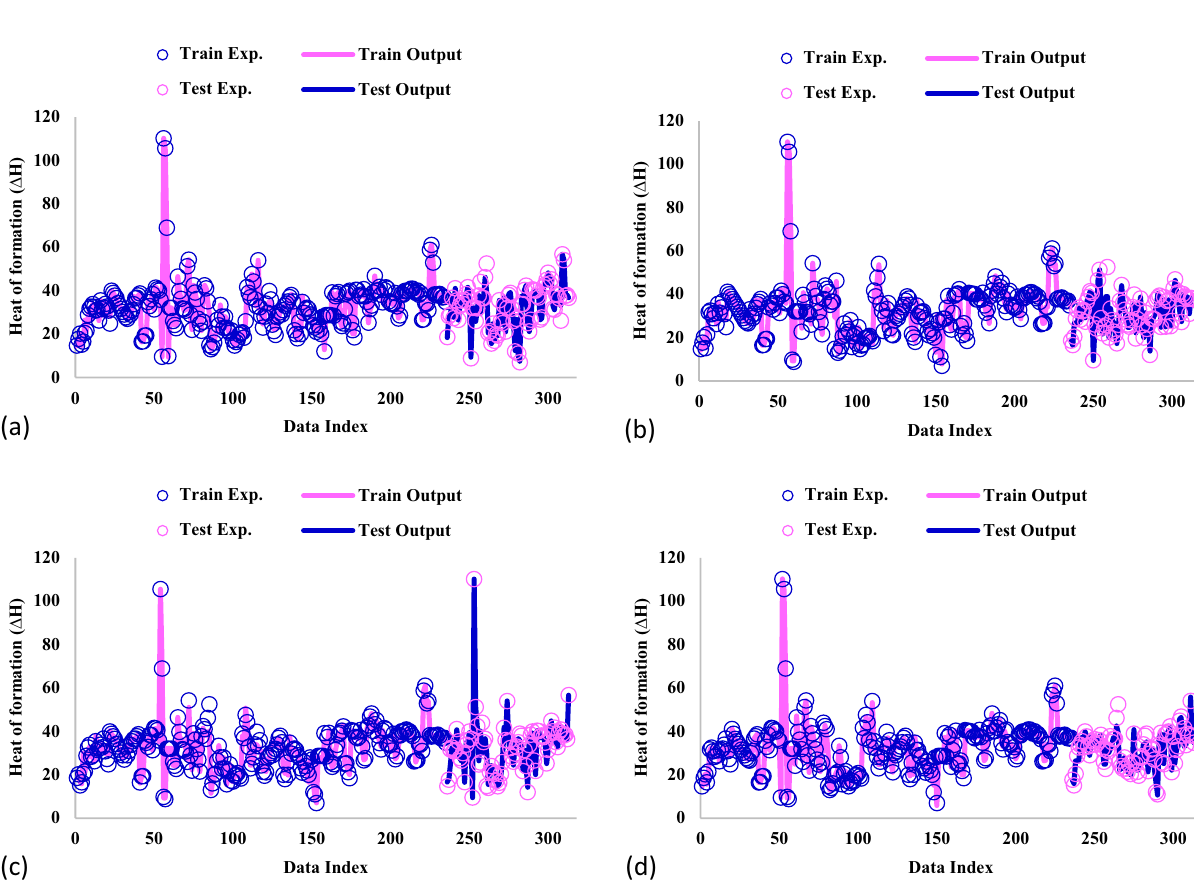
Table 1. The calculated statistical parameters of proposed GPR models.